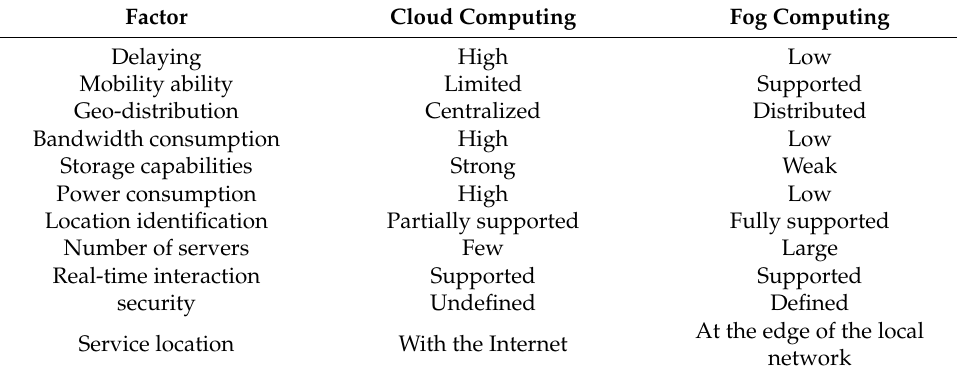
Table 4. Difference between cloud computing and fog